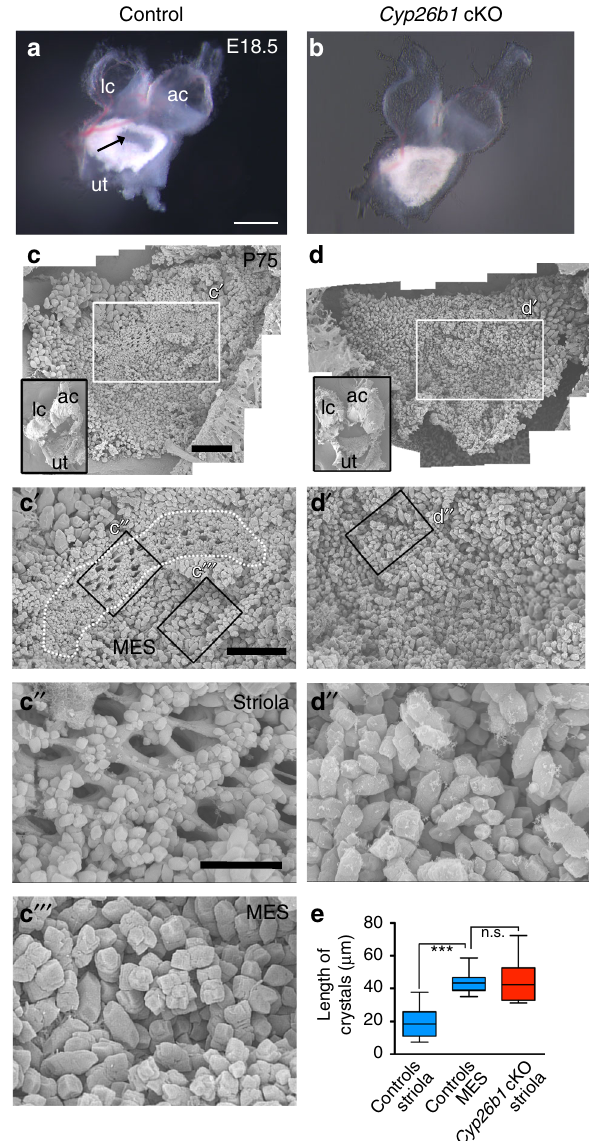
Fig. 3 Loss of regional differences in the otoconia of Cyp26b1 cKO utricles. a , b A dissected utricle (ut), anterior (ac), and lateral cristae (lc) of Foxg1 Cre ;Cyp26b1 lox/ + control ( a ) and Cyp26b1 cKO ( b ) ears at E18.5. In control utricle, the striola region shows a clearance of the otoconia (arrow in a ), which is missing in Cyp26b1 cKO utricles. c – e SEM of otoconia in Foxg1 Cre ;Cyp26b1 lox/ + controls ( c – c ‴ ) and Cyp26b1 cKO ( d – d ″ ) utricles at P75. Insets show low-power views of respective utricles. In controls ( c ′ , c ″ , c ‴ ), the striolar region (dotted outline) shows otoconia with smaller crystals ( c ″ , e , 19.7 ± 1.5 μ m, n = 22 crystals) and perforated holes in the subcupular meshwork layer ( c ″ ), whereas the medial extrastriolar region (MES) shows larger otoconia ( c ‴ , e , 40.2± 2.2 μ m, n = 23, P < 0.0001). There is no clear regional difference in the size of the otoconia in the Cyp26b1 cKO mutant utricle ( d , d ′ ), and the otoconia crystals in the presumptive striolar region are larger in size ( d ″ , e , 42.9 ± 3.1 μ m, n = 21), comparable to those found in MES of controls ( c ‴ , P = 0.6509). The one- way ANOVA with multiple comparisons was applied. In the box plots, bounds of box span from 25 to 75% percentile, center line represents the median, and whiskers represent the minimum and maximum of the data points. *** P < 0.001. Scale bars: 200 μ m for a , b , 300 μ m for c , d , and c ′ , d ′ , and 100 μ m for c ″ , c ‴ , d ″ . n.s., not signi fi